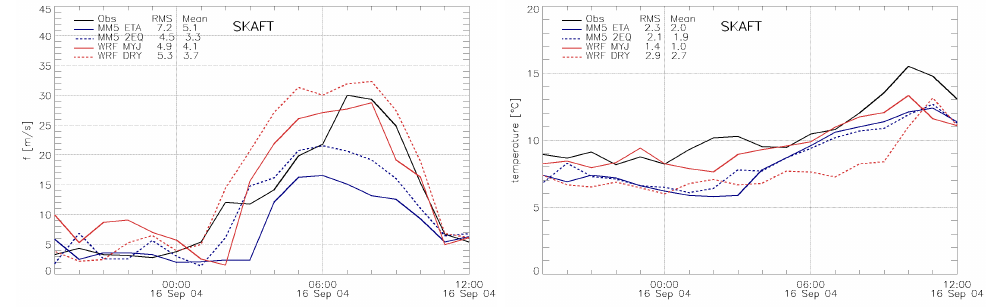
Figure 13: Observed (solid black) and simulated (solid blue – MM5/ETA, blue Fig. 13. Observed (solid black) and simulated (solid blue – MM5/ETA, blue dash – MM5/2EQ, solid red – WRF/MYJ, red dash – WRF/MYJ dash – MM5/2EQ, solid red – WRF/MYJ, red dash – WRF/MYJ DRY) 10 metre wind speed [ms − 1 ] (left) and 2-metre temperature [ ◦ C] (right) at station SKAFT (WMO# 4172) in the lee of Mt. Öræfajökull.